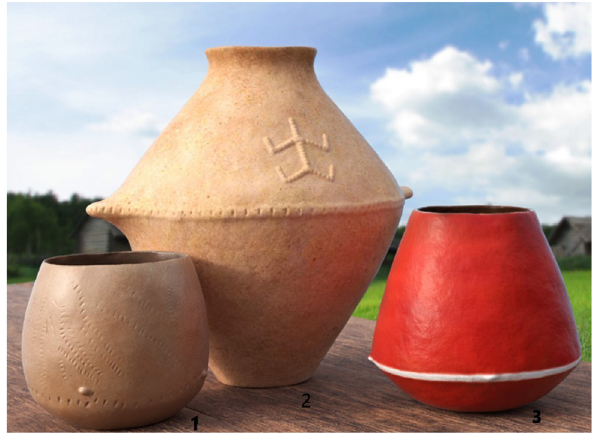
Figure 7: Reconstructed vessels of MC from Targowisko sites 12 – 13 ( 1 and 3 ) and 14 – 15 ( 2 ) ( acc. to Osiadacz, 2017 )